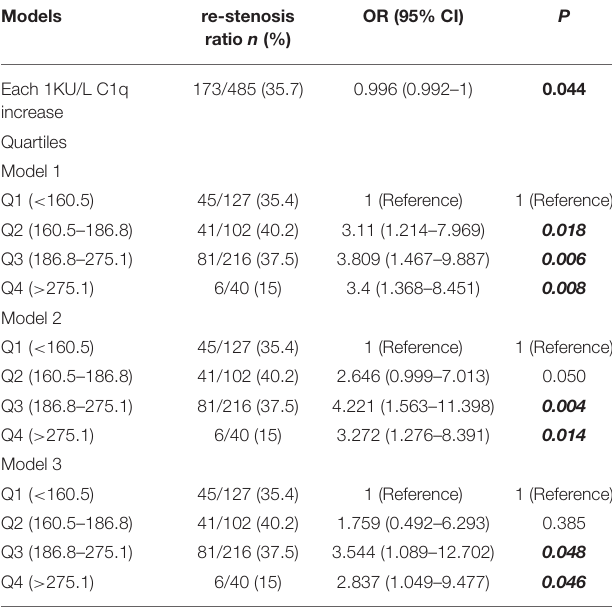
TABLE 5 | Associations of C1q and 1-year re-stenosis after coronary revascularization. Models